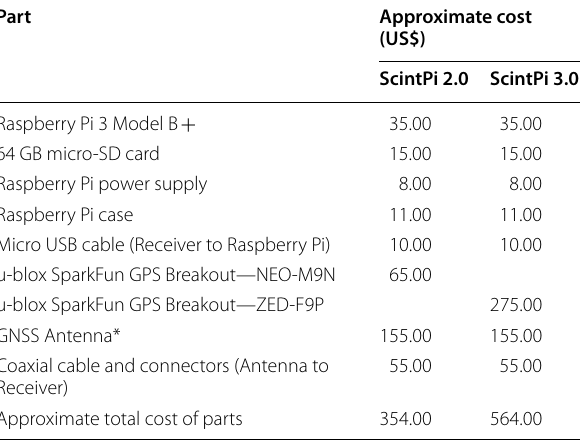
Table 1 List of main parts used to build ScintPi 2.0 and 3.0 and